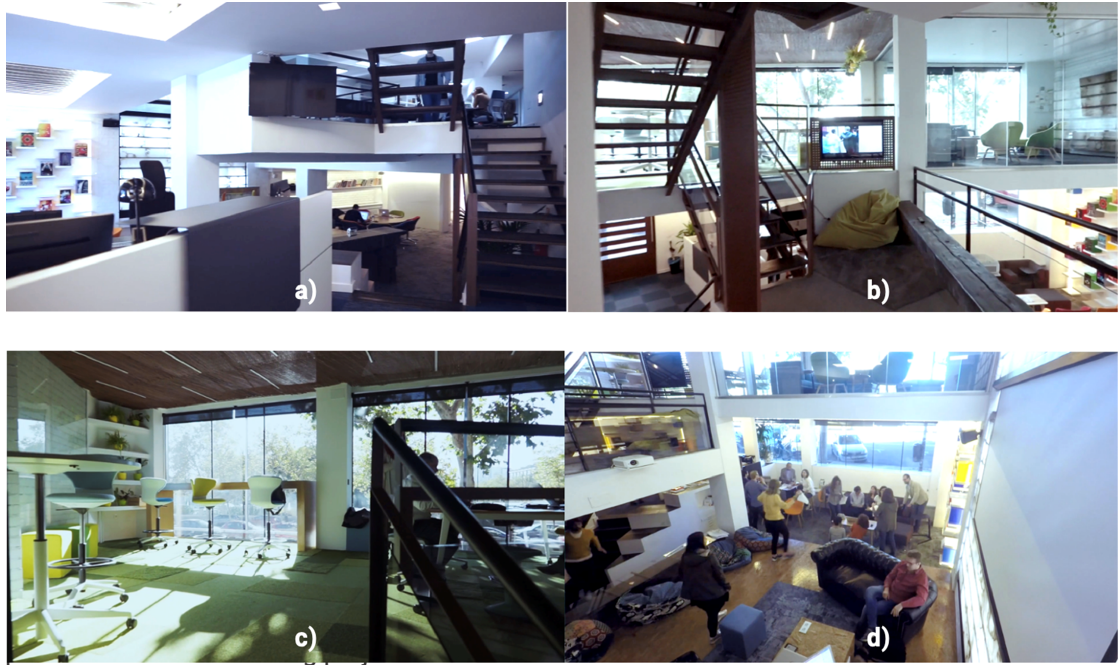
Figure 2. Interior photographs of the office space analyzed: ( a ) Entrance; ( b ) Pradera; ( c ) Jardín; ( d ) Altar.